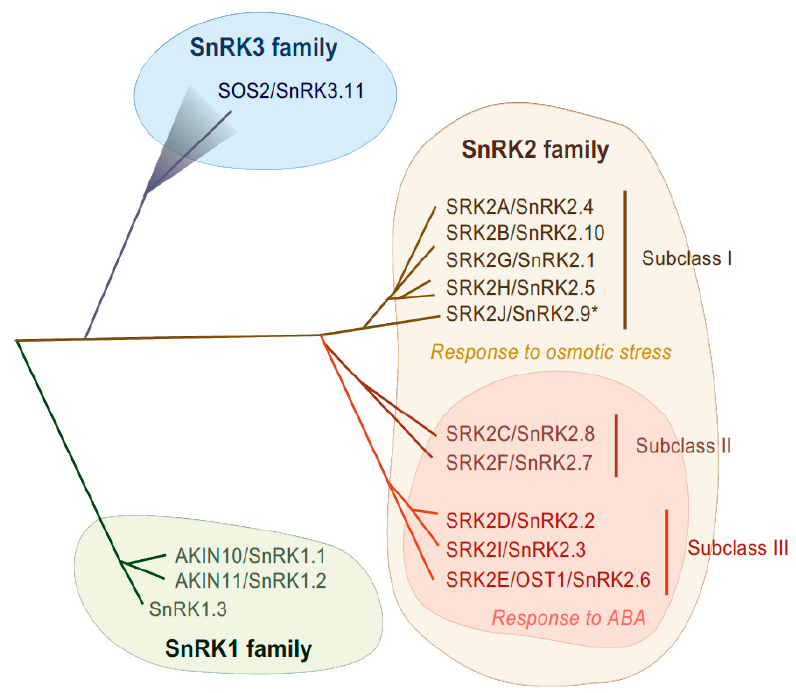
Figure 1. Phylogenetic tree of SnRK family in Arabidopsis. In Arabidopsis, SnRK1, SnRK2 and SnRK3 contain 3, 10 and 25 genes, respectively. SnRK2 family is classified into three subclasses, subclass I, II and III. SnRK2 kinases are activated in response to osmotic stress, except for SRK2J (indicated by *). Subclass II and Subclass III SnRK2s are activated in response to ABA.